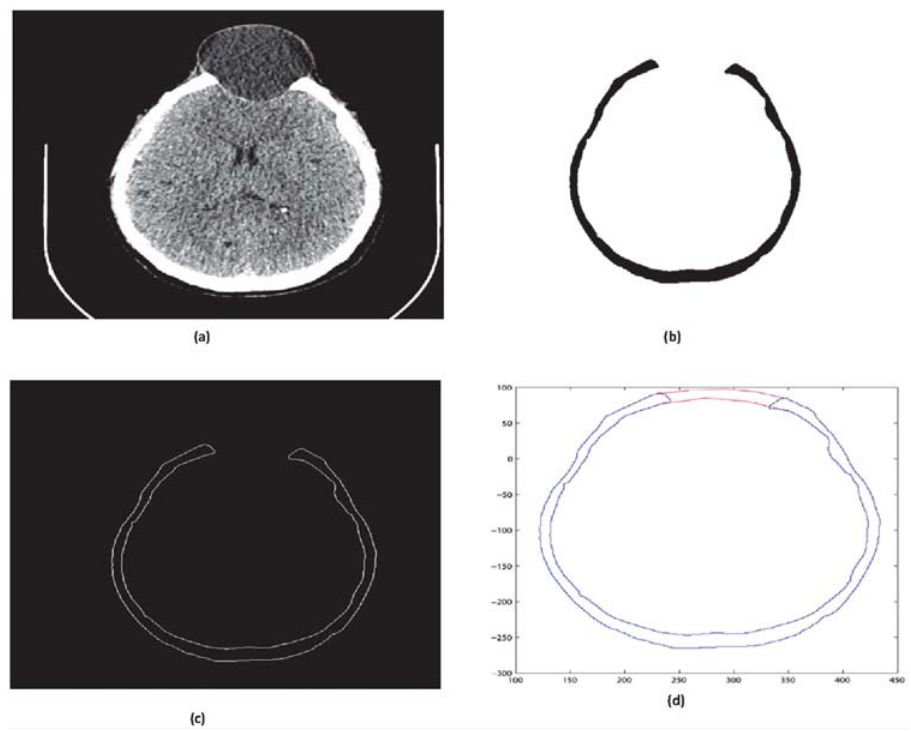
Fig 7. CT scanned data of slice 147. (a)Original image (b) Binary image (c) Boundary (d)Reconstructed missing part using rational cubic Ball